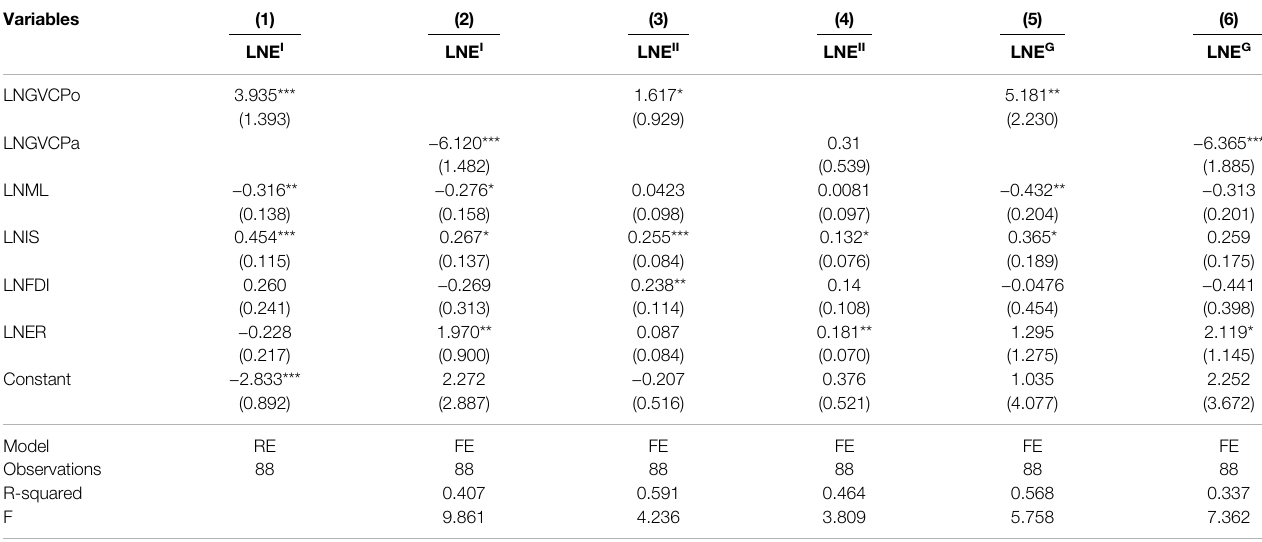
TABLE 3 | Empirical results of the impact of the GVC embeddedness on the GIVC.